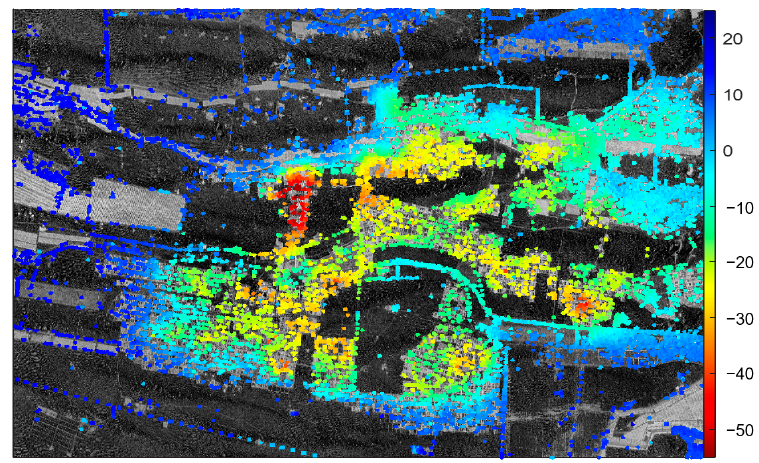
Figure 10. The land deformation estimated using PSI.